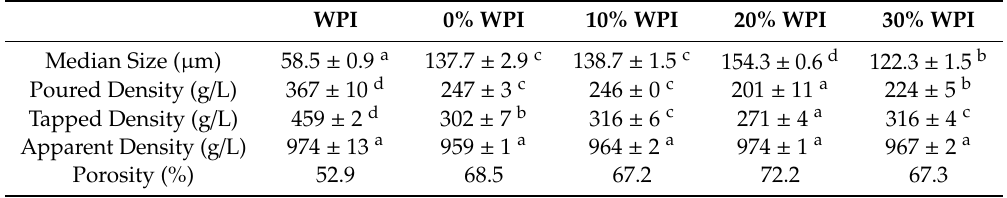
Table 1. Particle size, densities and porosity of the original WPI powder (WPI) and the agglomerated powders with di ff erent % WPI in the WPI binder solution (0% WPI to 30% WPI).